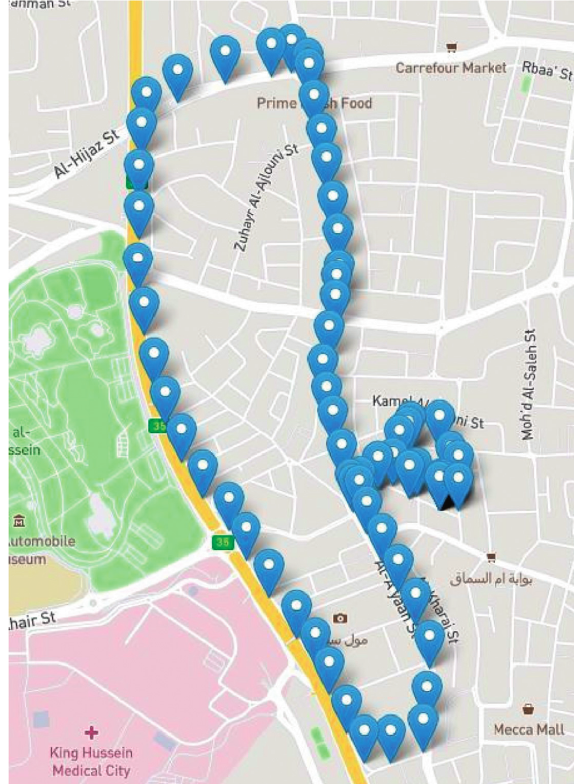
Figure 19: A very accurate trip path.